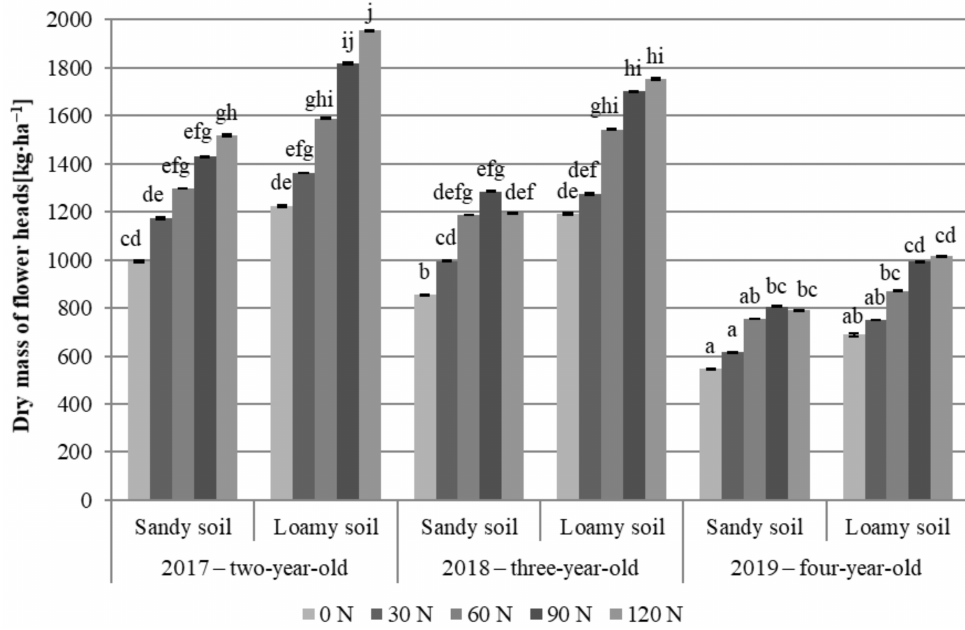
Figure 2. Yield of A. chamissonis flower heads depending on the experimental factors; 0 N, 30 N, 60 N, 90 N, 120 N—nitrogen doses (kg · ha − 1 ). Values designated by different letters are significantly different ( p = 0.05) (Tukey test, p <